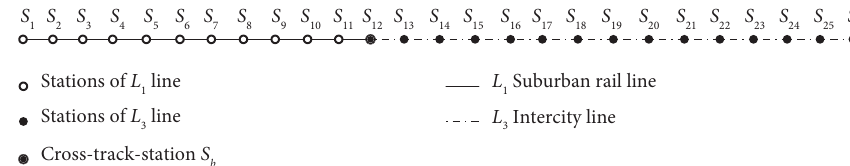
Figure 10: Line schematic in the computing case. Table 3: Parameter values of the model.